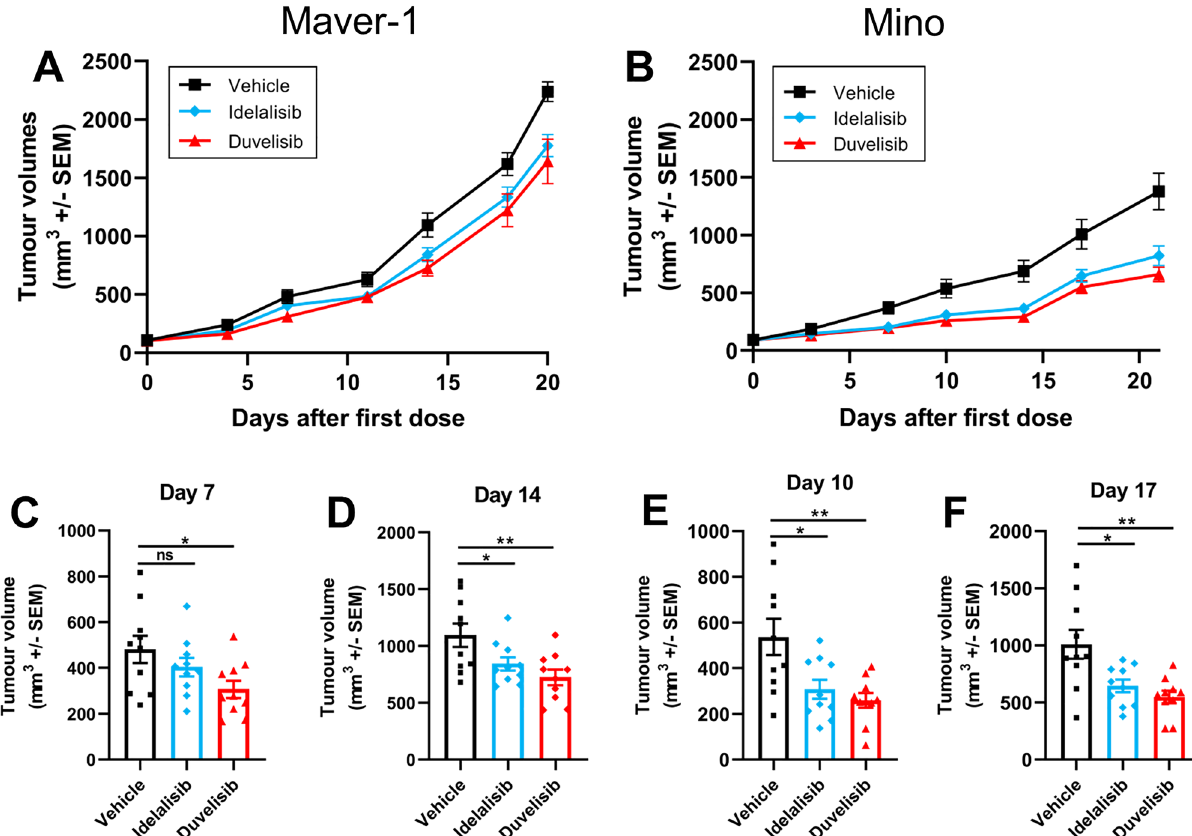
Figure 3. PI3K inhibition reduces tumour growth in a xenograft model. 5 × 10 6 Maver-1 or Mino cells were injected subcutaneously into SCID mice. When the tumours had reached 60–160 mm 3 the animals were subjected to either vehicle control or idelalisib/duvelisib at 50 mg/kg. Tumour volumes were measured with a calliper in two dimensions. Tumour volumes of ( A ) Maver-1 and ( B ) Mino cells in engrafted animals over a period of 21 days. ( C , D ) Data from xenografts of Maver-1 in the individual mice shown in ( A ) at Day 7 ( C ) and Day 14 ( D ). ( E , F ) Data from xenografts of Mino in the individual mice shown in ( B ) at Day 10 ( E ) and Day 17. ( F ) Data in all parts of the figure are presented as mean ± SEM from 10 individual mice. * P < 0.05; ** P < 0.001. Statistical significance was determined using the Student’s